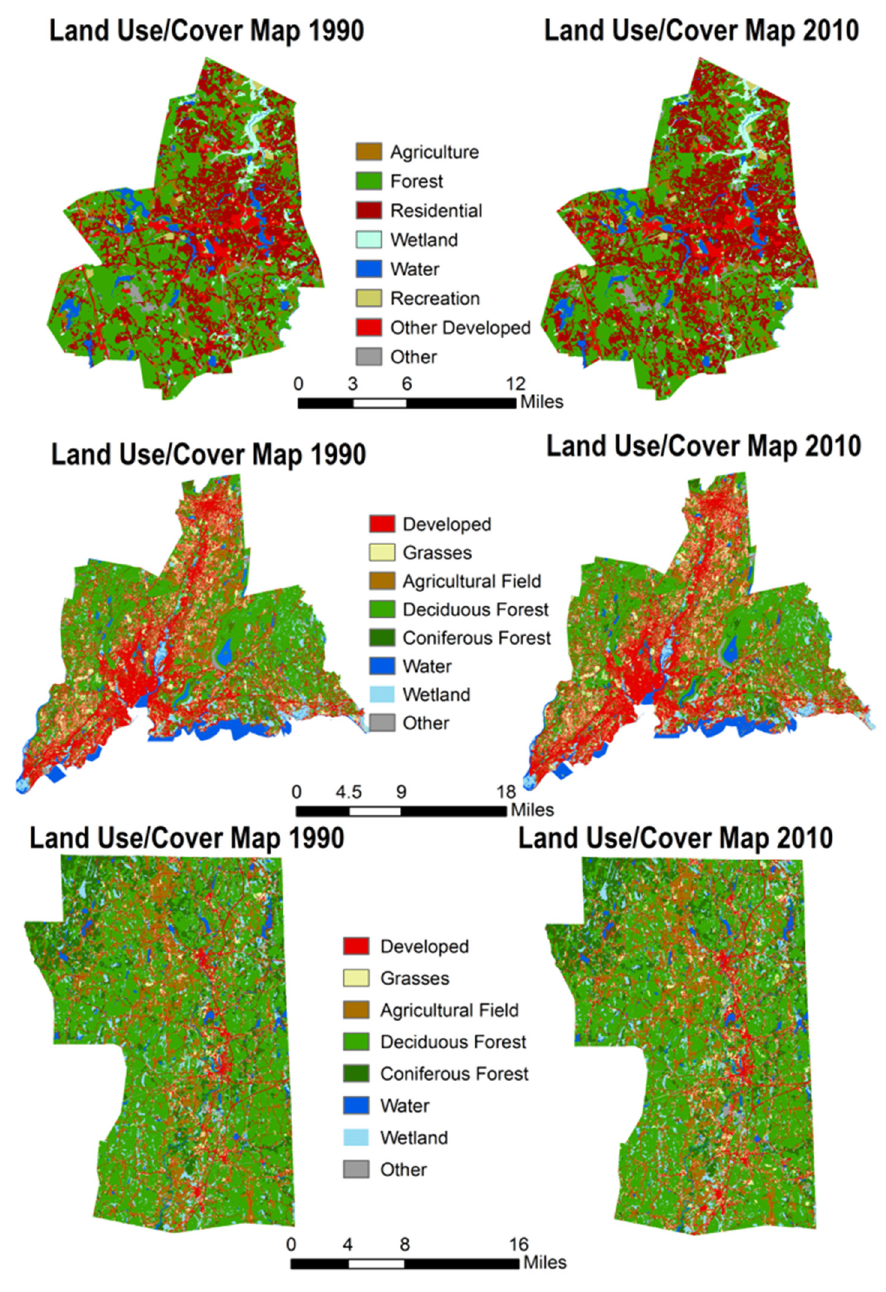
Figure 3. The land use / land cover data of the three planning regions, top: MetroWest, MA; middle: SouthCentral, CT; bottom: Northeastern, CT. Table 2. Acronyms, names, and descriptions of the driving forces used in this study.